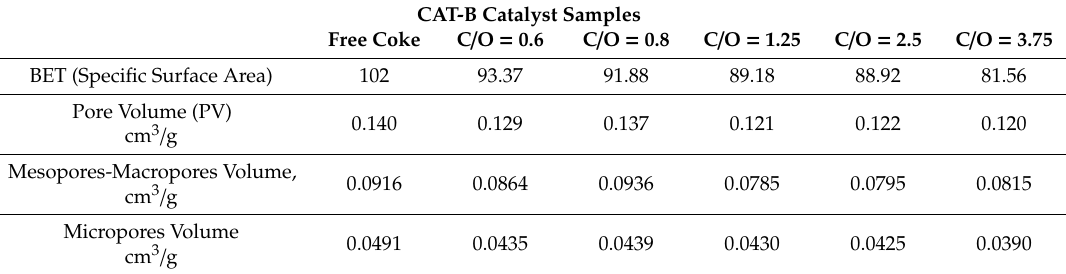
Table 5. Specific surface areas (SSA) (m 2 / g) and pore volumes (PV) (cm 3 / g). Mesopore volumes (cm 3 / g) for CAT-B are determined following catalytic cracking runs at 550 ◦ C and 7 s, using di ff erent C / O ratios. SD on repeats: +/ − 3 m 2 /